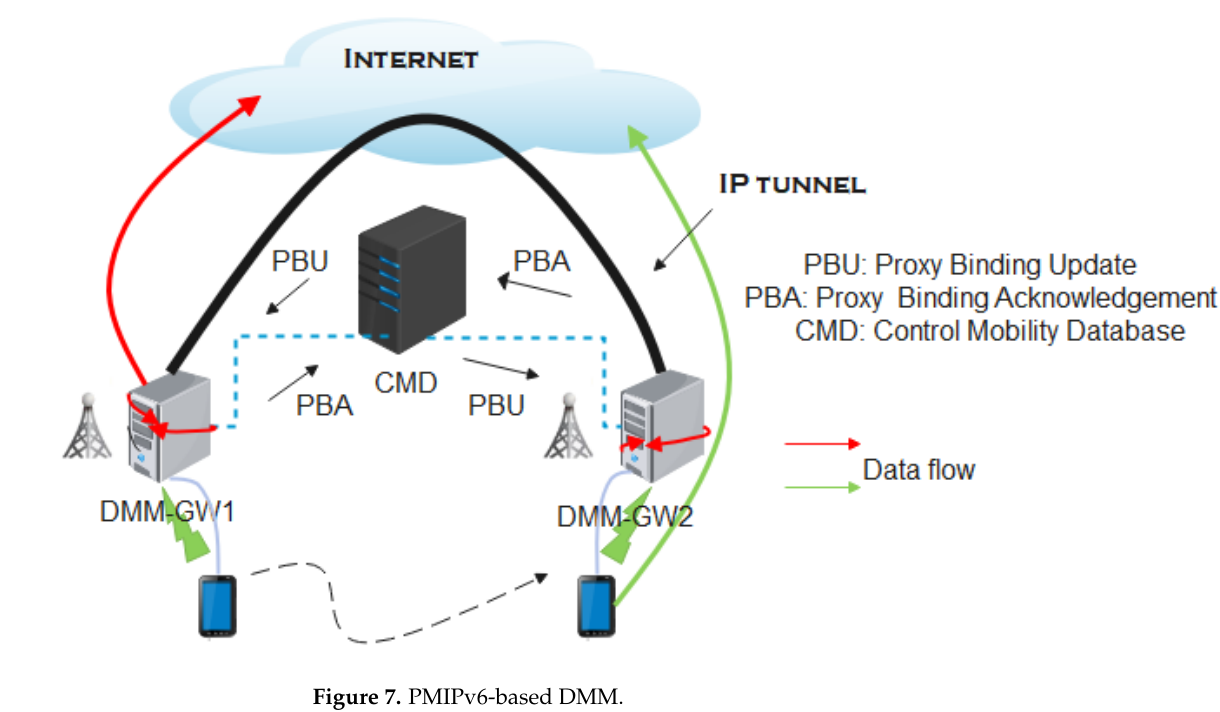
Figure 7. PMIPv6-based DMM.